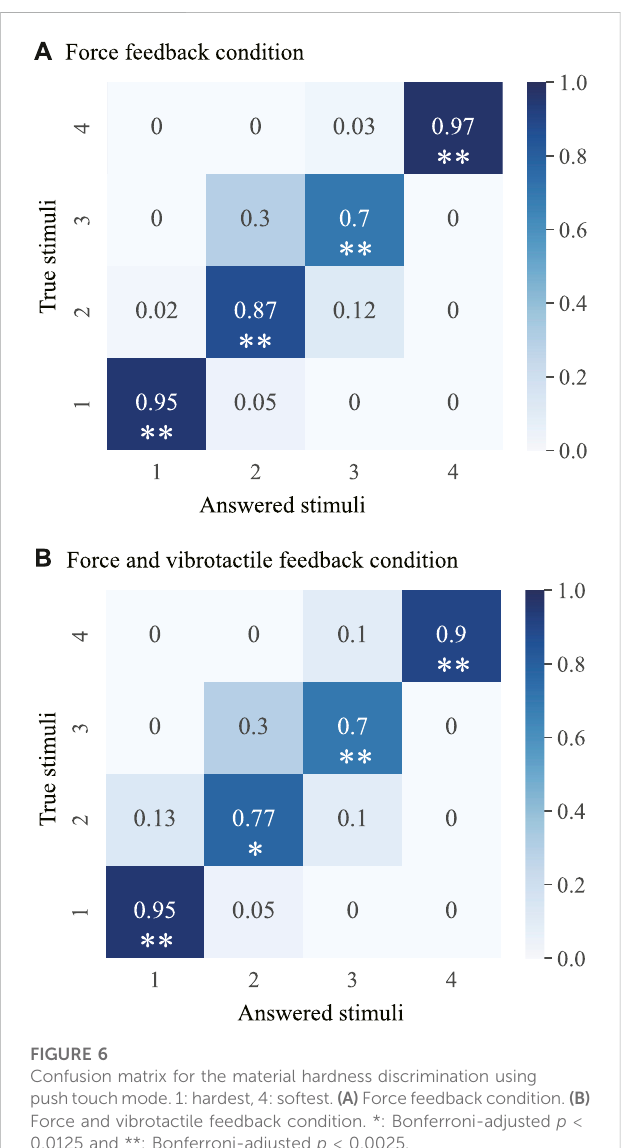
Confusion matrix for the material hardness discrimination using pushtouchmode.1:hardest,4:softest. (A) Forcefeedbackcondition. (B) Force and vibrotactile feedback condition. *: Bonferroni-adjusted p < 0.0125 and **: Bonferroni-adjusted p < 0.0025.